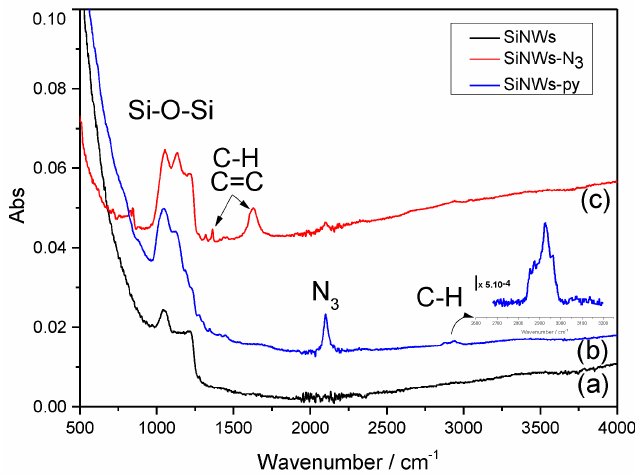
Figure 7. Infrared spectrum of unmodified silicon nanowires ( a ), azide-modified silicon nanowires ( b ), pyrene-modified silicon nanowires ( c